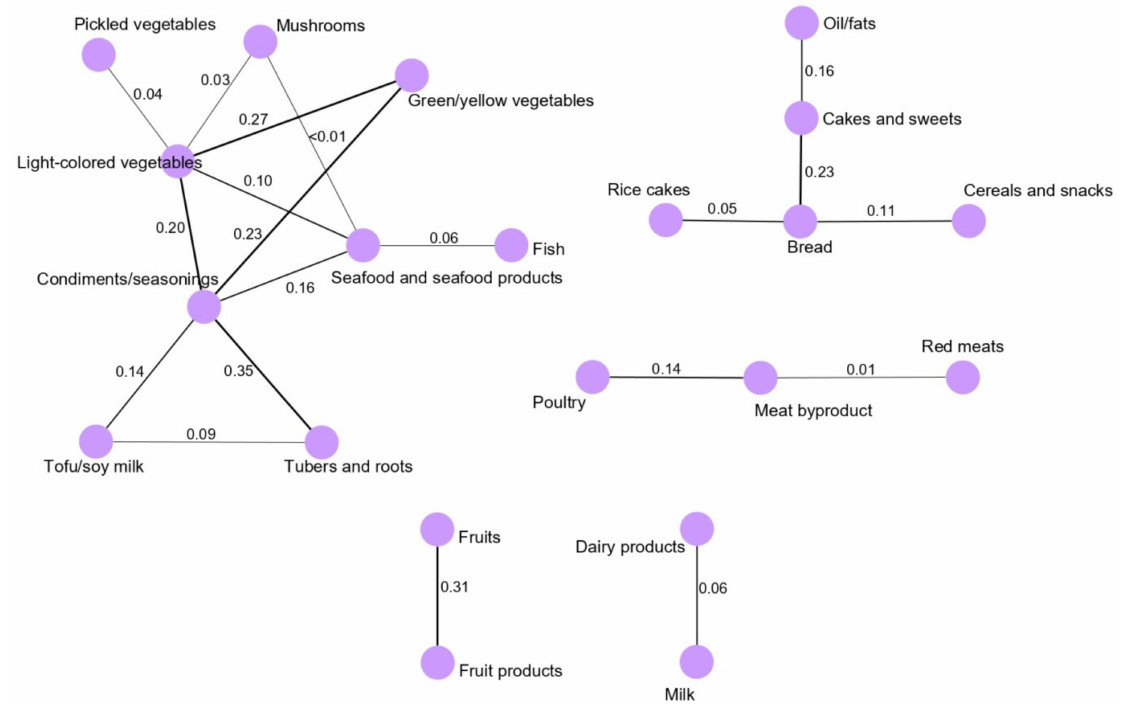
Figure 3. Dietary intake networks for the female population derived from GGM. Nodes represent the food group variables, and edges represent the conditional dependencies reflected by partial correlation coefficients between food groups. The thickness of the edge is proportional to the strength of the correlation between food groups. The absence of an edge between two food groups indicates conditional